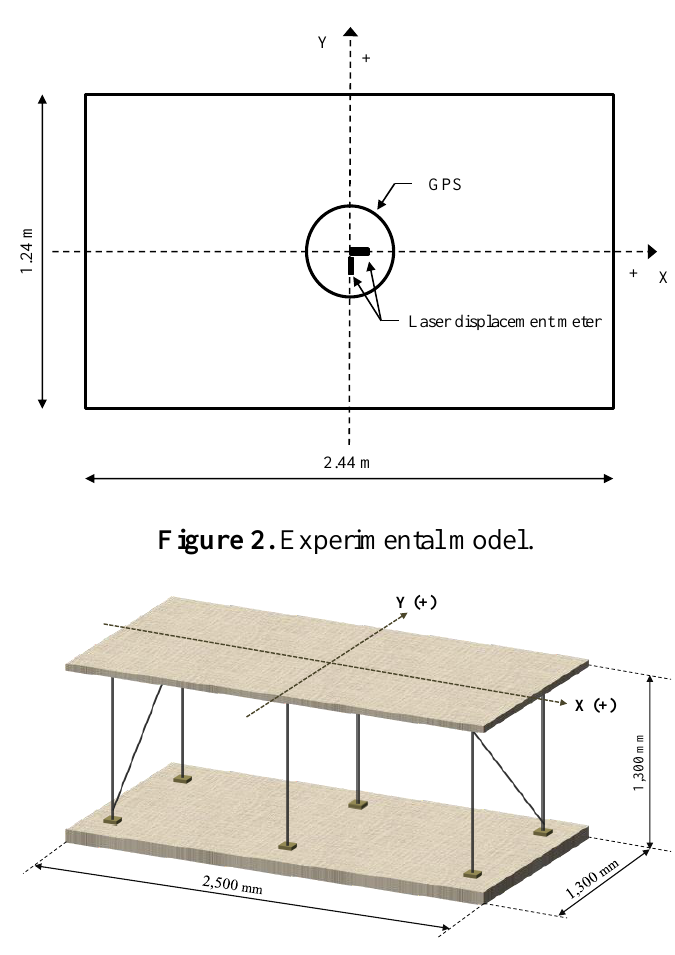
Figure 1. Accuracy test scheme for the CDGPS.